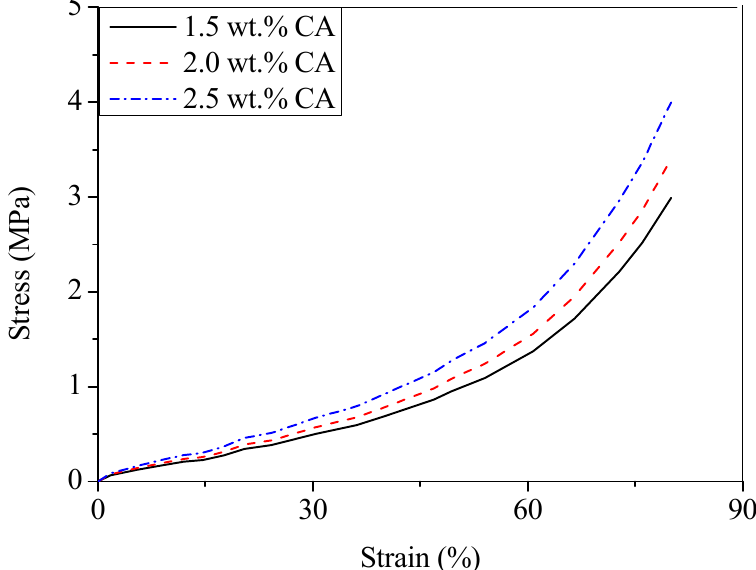
Figure 3. Typical compression stress–strain curves of cellulose aerogel (CA) with various cellulose concentration.